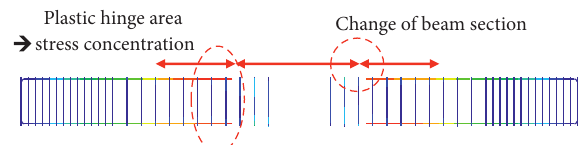
Figure 21: Stress distribution of